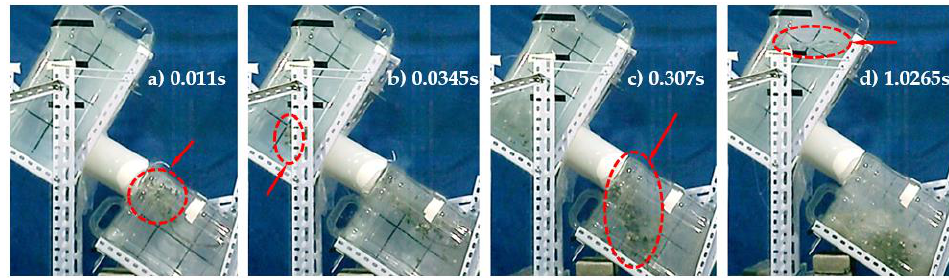
Figure 7. Process for experimental cas e 3 (β = 30°, h = 305 mm).